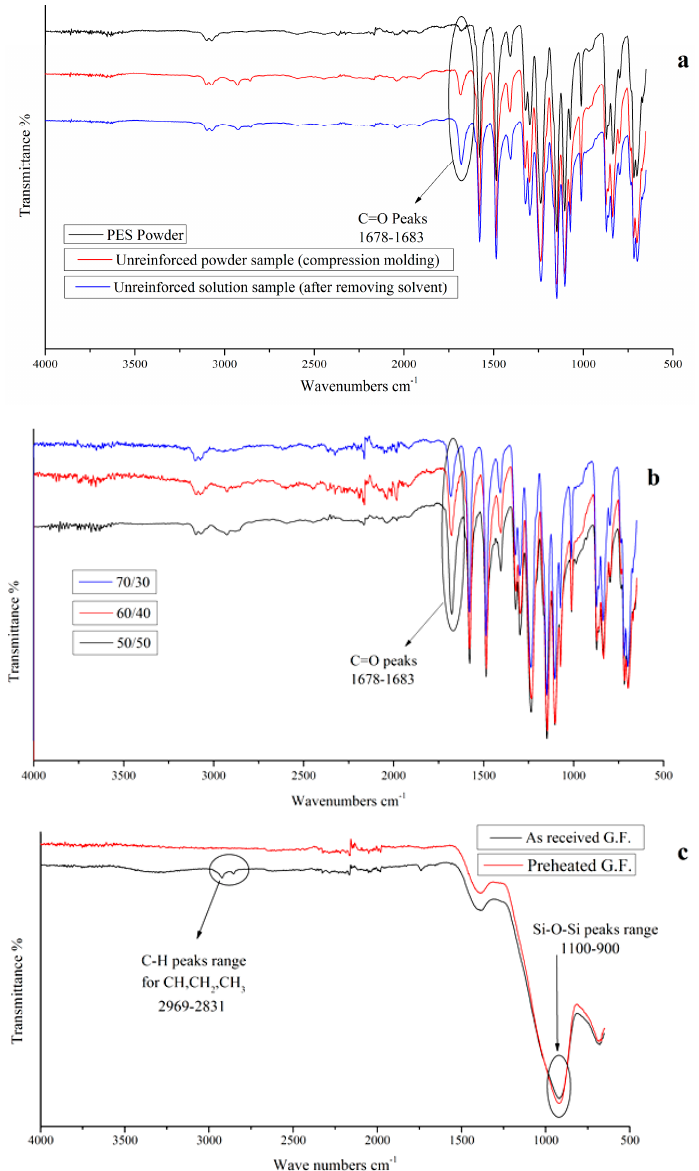
Figure 4. FTIR spectra for ( a ) initial PES powder, unreinforced PES powder sample after compression molding, and unreinforced solution sample after removing solvent. ( b ) PES impregnated composites (route 4) with different fiber to polymer weight ratios. ( c ) As-received GF and GF preheated at 350 °C.